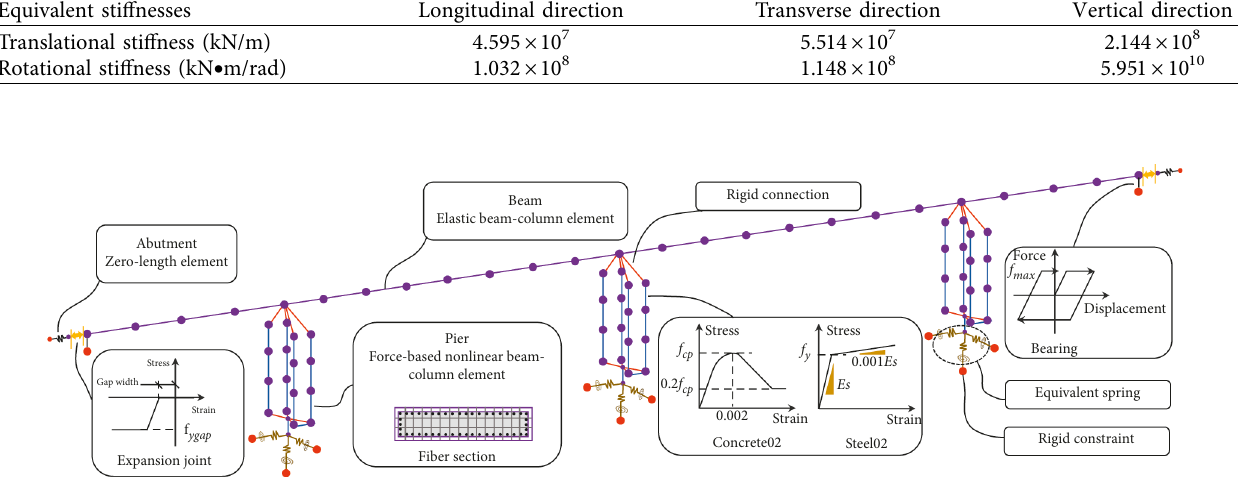
Figure 3: Analytical model of the continuous rigid frame bridge.